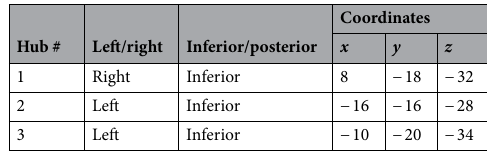
Table 2. Location of fetal cerebellar